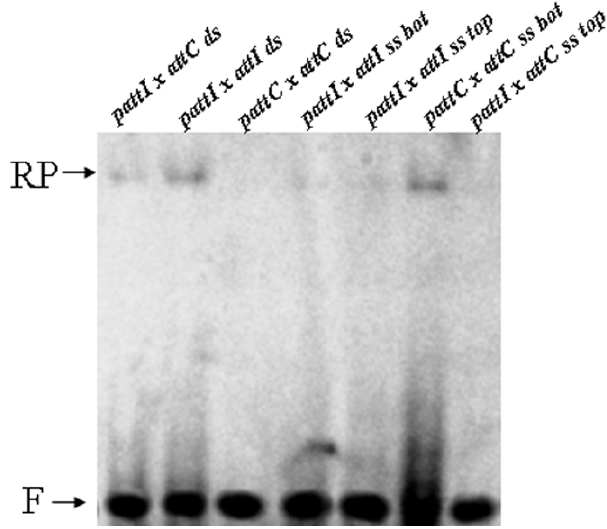
Figure 8. In vitro recombination catalyzed by wild type IntI1 in presence of double- or single-stranded substrates. Reactions were performed for 90 min in the presence of purified enzyme (5 pmoles), 0.1 pmoles of linear radiolabeled double-stranded (ds) or single- stranded (bottom strand: ss bot, or top strand: ss top) recombination sites attI1 or attC and 0.1 pmoles of pGEM-T- attI1 or pGEM-T- attC under standard conditions described in materials and methods section. Products were loaded on 1% agarose gel and autoradiographied. F: free recombination sites, RP: recombination products.